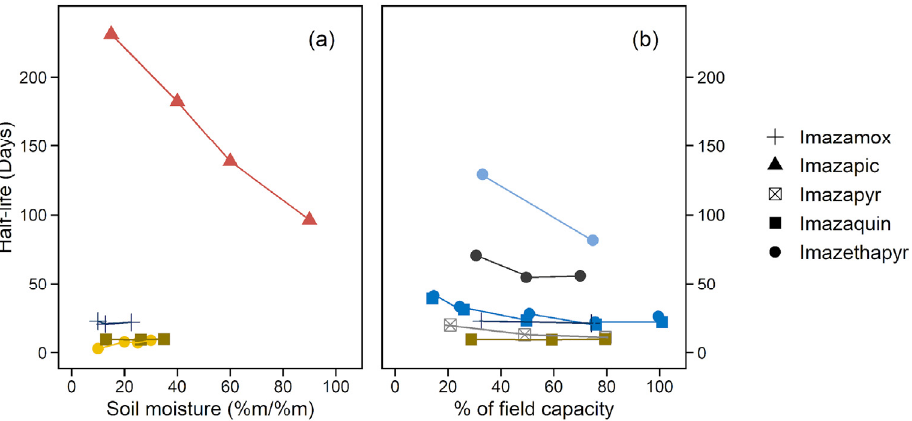
Figure 8. Relationship between imidazolinone half-life (days) and soil moisture (%m/%m) ( a ), and percentage field capacity ( b ).